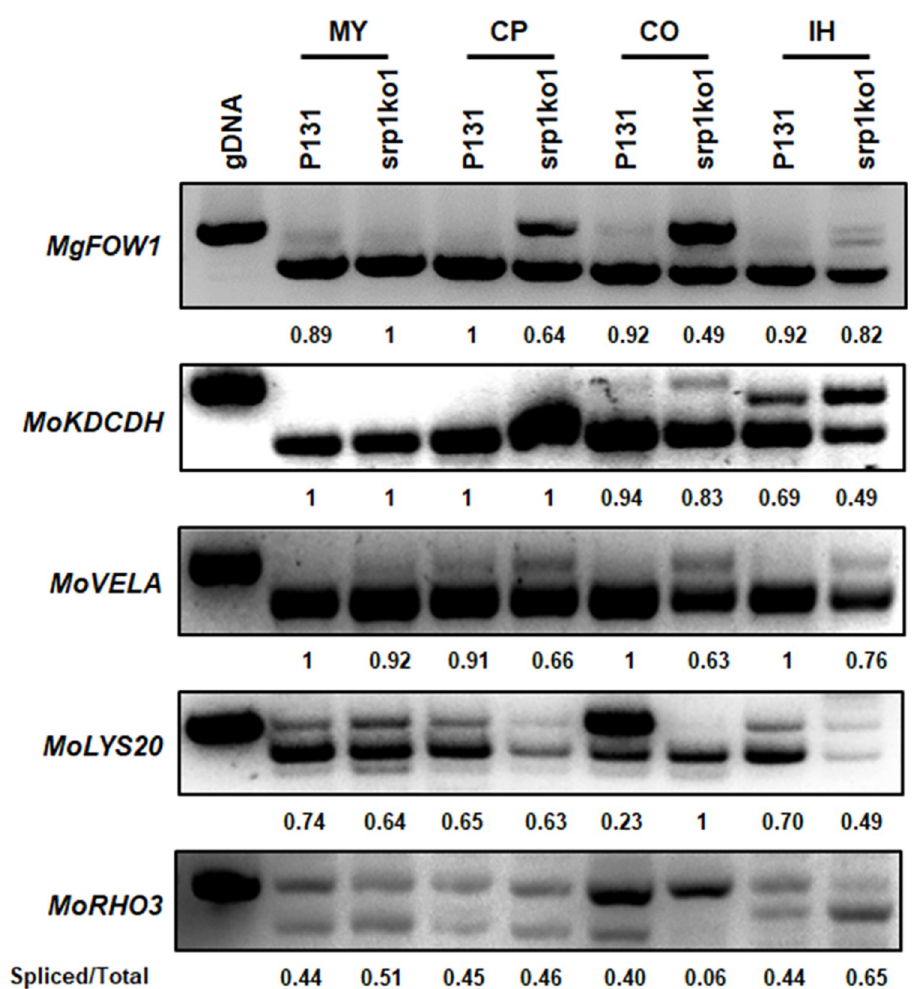
Fig 6. MoSrp1 regulates alternative intron splicing at different developmental stages. RT-PCR analyses show splicing efficiency of the introns of five reported genes, MgFOW1 , MoKDCDH , MoVELA , MoLYS20 , and MoRHO3 , in strains P131 and srp1ko1 at different developmental stages, including mycelium (MY), conidiophores (CP), conidium (CO), and invasive hyphae (IH). The corresponding genomic DNA (gDNA) fragment amplified was used as a control with an un-spliced intron. The ratio between the spliced and the total introns was shown at the bottom of each line.